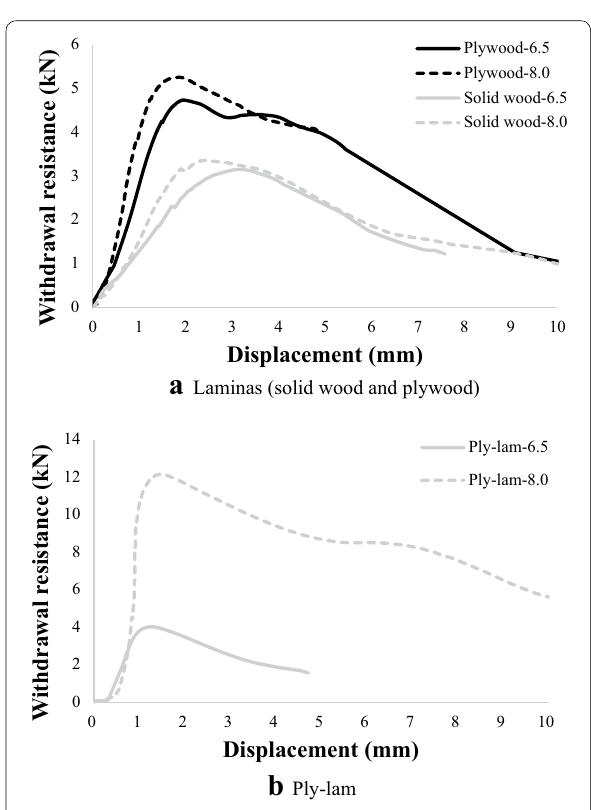
Fig. 6 Withdrawal resistance and displacement curve of test